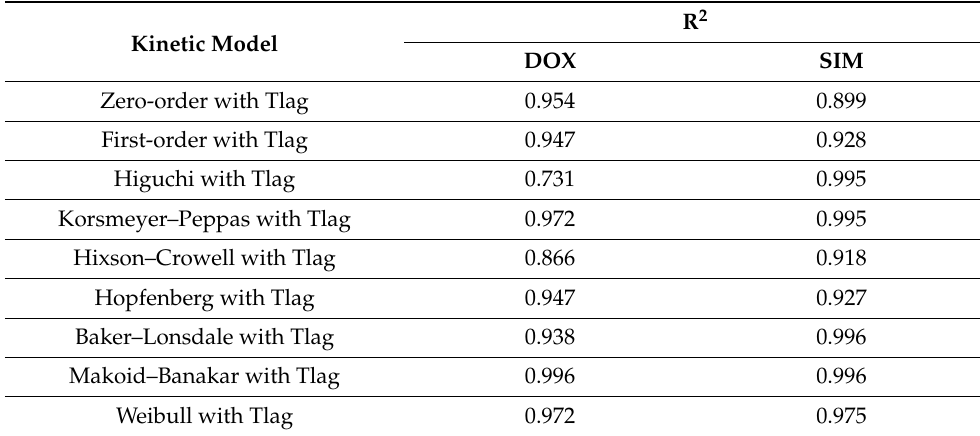
Table 5. The correlation coefficient (R 2 ) of SIM and DOX when different release kinetic models were